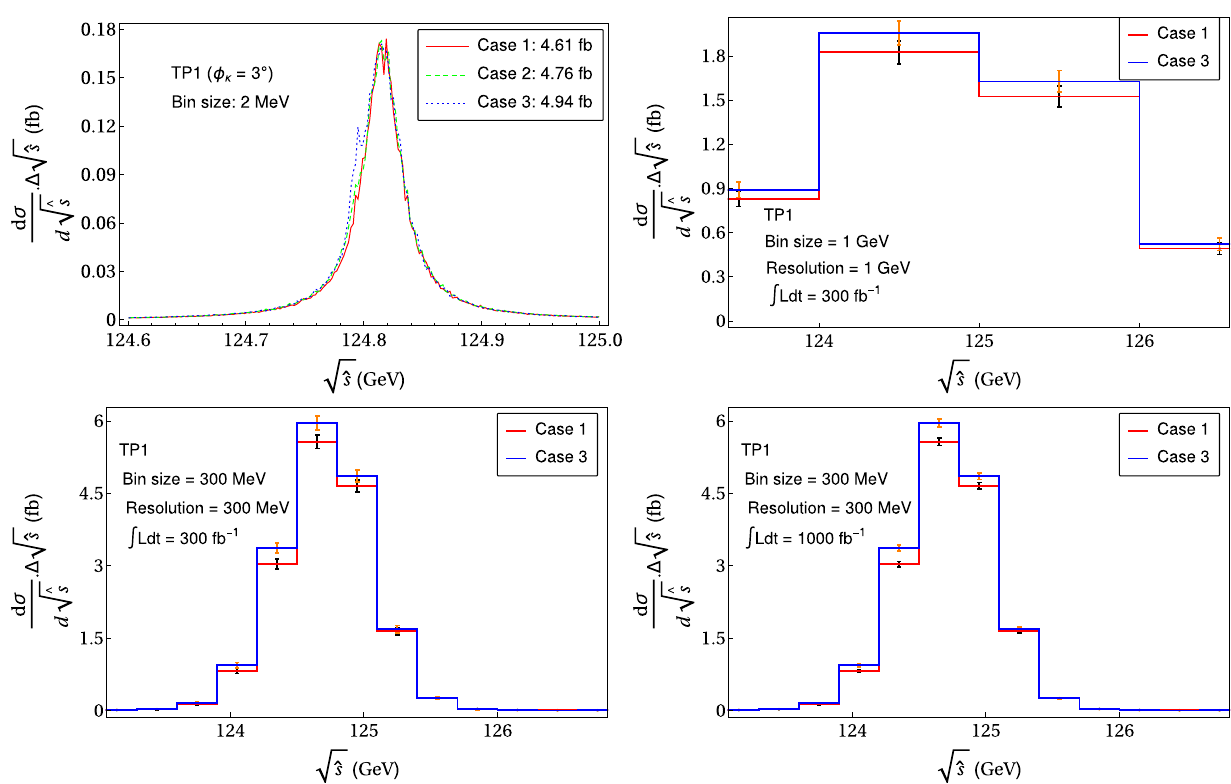
Fig. 7 Top The differential distributions for TP1 without convolution ( left ) and after convolution with a Gaussian of width 1GeV for an inte- grated luminosity of 300 fb − 1 ( right ). Bottom TP1 distributions after